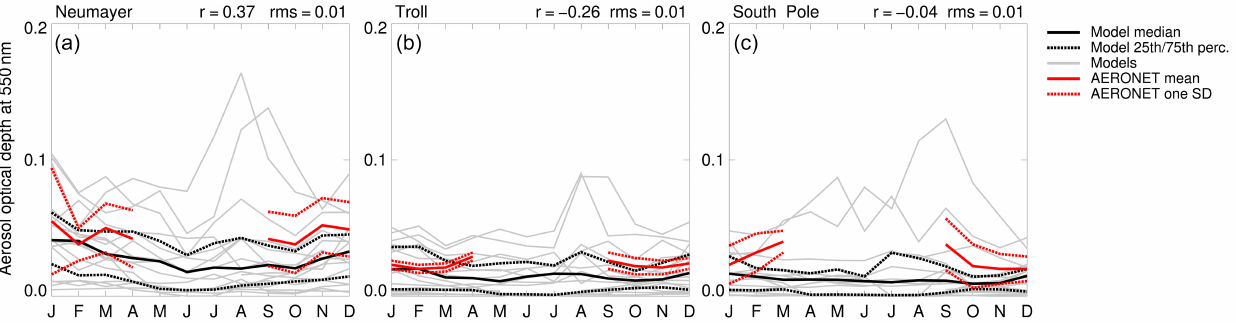
Figure 7. As Fig. 2, but for three Antarctic sites: Neumeyer 70 ◦ S, 8 ◦ W (a) , Troll 72 ◦ S, 2 ◦ E (b) , and South Pole 90 ◦ S, 0 ◦ E (c) , with values from Tomasi et al. (2015).